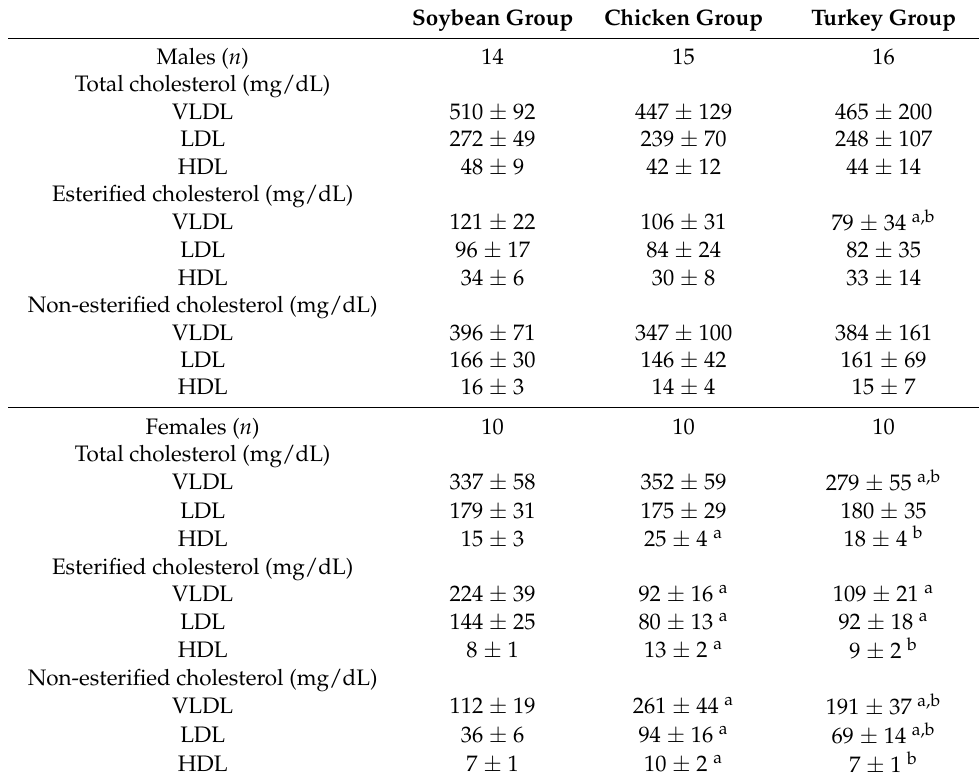
Table 4. Distribution of cholesterol in plasma lipoproteins.